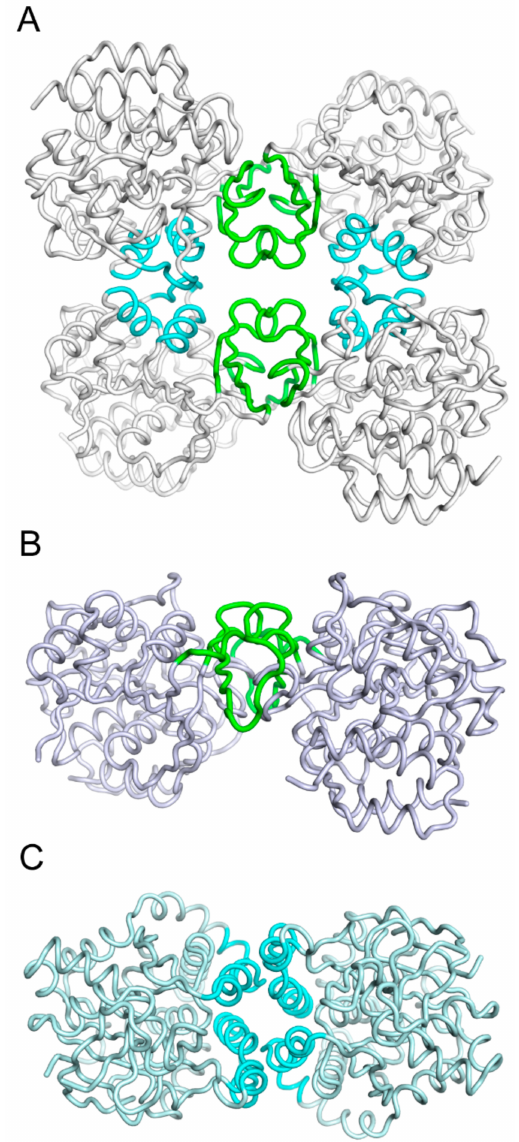
Figure 5. Oligomerization of NH proteins. ( A ) Ribbon diagram of the tetrameric group I IU-NH from C. fasciculata . The quaternary structure is achieved through two interaction surfaces, a major (colored green) one largely involving the β 8 and β 9 strands that are not part of the central core sheet, and a minor (cyan) one that is composed of residues from the loop connecting strand β 3 to helix α 3, and helices α 4.1 and α 5.2. ( B ) Ribbon diagram of the dimeric plant NH. This dimer, oriented in the figure as the C. fasciculata isozyme in the top panel, is stabilized by extensive interactions between residues corresponding to the major surface in the group I tetramers. The conformation of the secondary structural elements corresponding to the minor interface is conserved; thus, the different amino acid compositions at the β 3- α 3 junction and α 4.1 and α 5.2 helices prevent the formation of the tetrameric structure. ( C ) Dimeric group II NH. Deletions in the β 8- β 9 region and the presence of two additional helices α 3.1 and α 3.2 in the region joining strand β 3 to β 4 allow a different mode